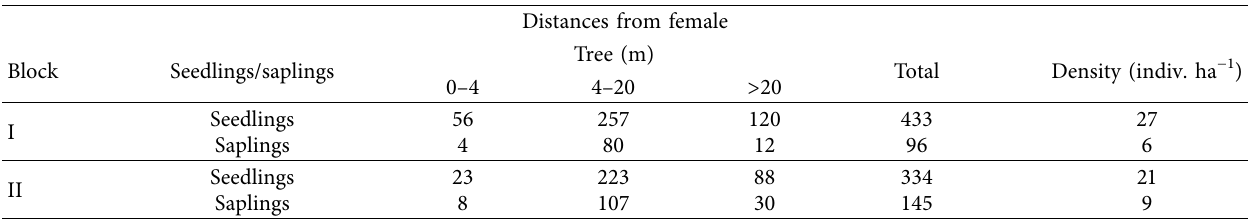
Table 4: Total number of seedlings and saplings, distances from female tree (m), and density of P. falcatus individuals in the two blocks in Dodola forest.